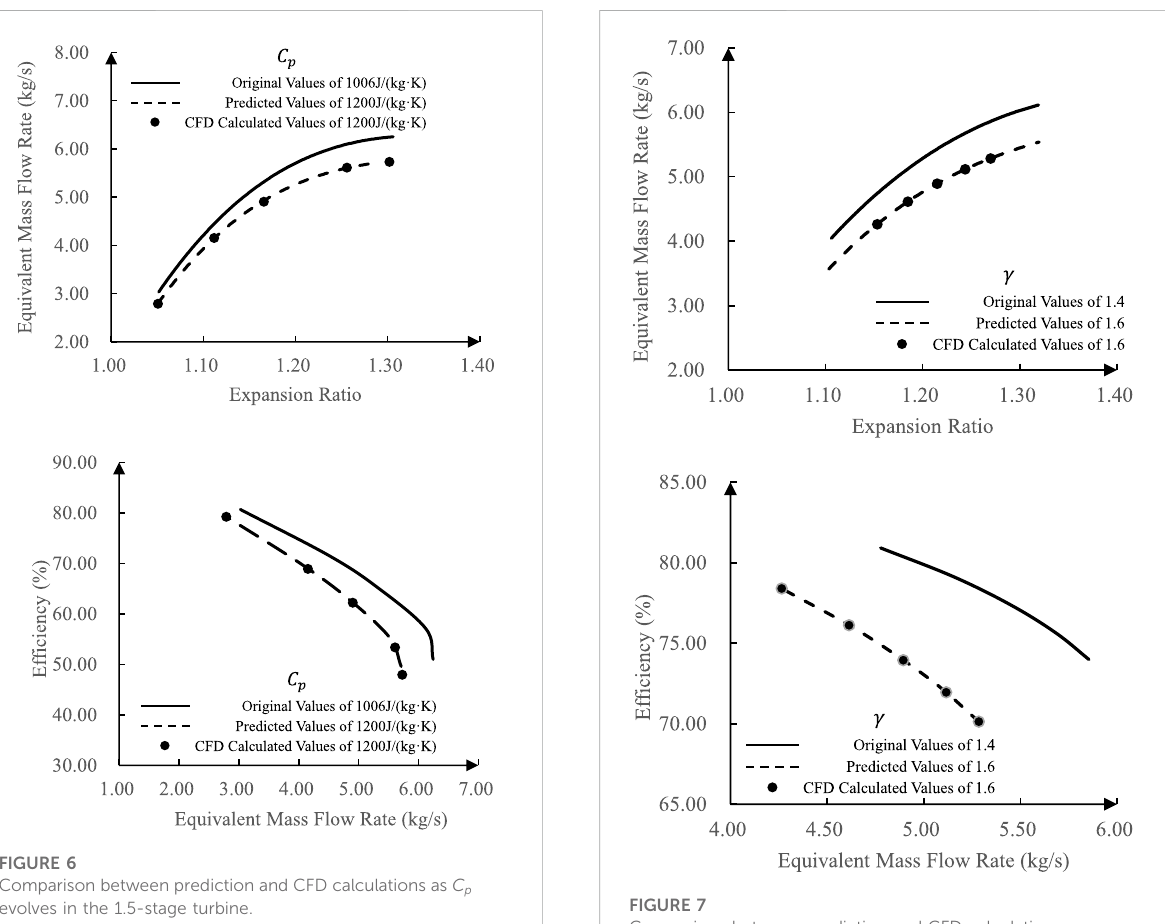
Comparison between prediction and CFD calculations as γ evolves in the 1.5-stage